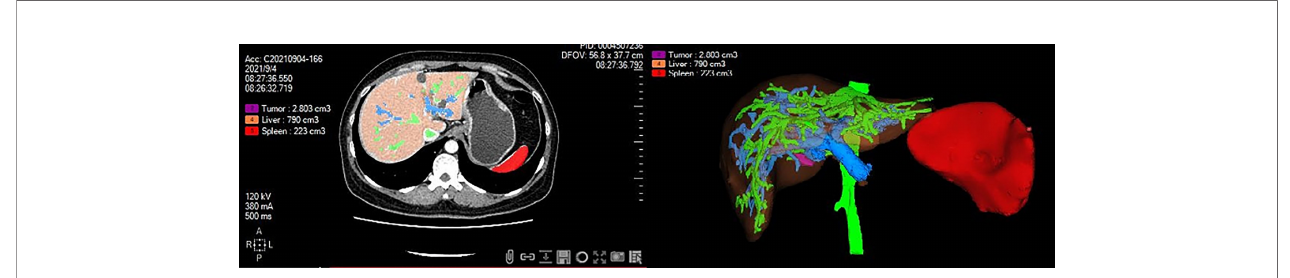
FIGURE 1 | Three-dimensional reconstruction of the spleen was performed for automated volumetry by using medical image analysis software. The splenic volume was calculated after volumetry of the spleen. Red color, spleen; Purple color, tumor; Orange color, liver; Green color, hepatic vein; Blue color,